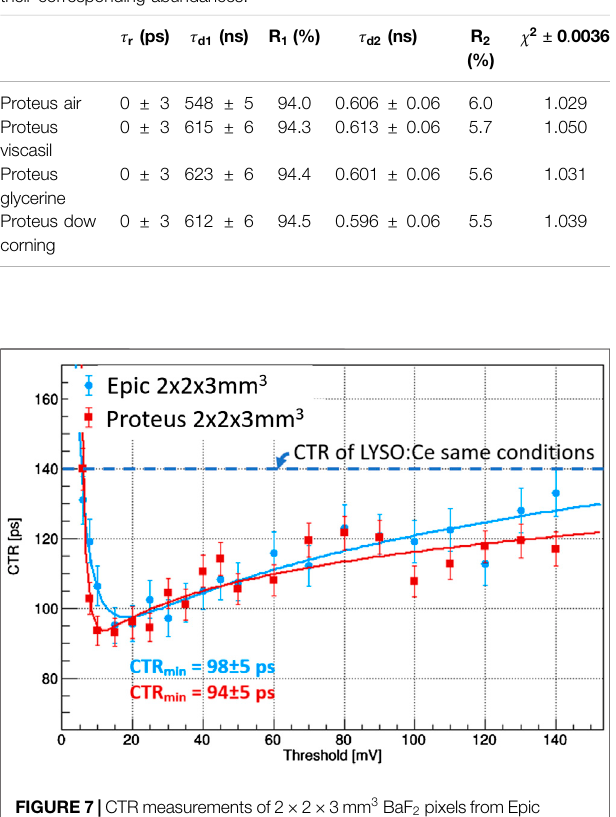
TABLE 5 | CTR measurements of 2 × 2 × 3mm 3 Ba F 2 pixels from Epic and Proteus, coupled to a S13370-CN of Hamamatsu, using various optical couplings.